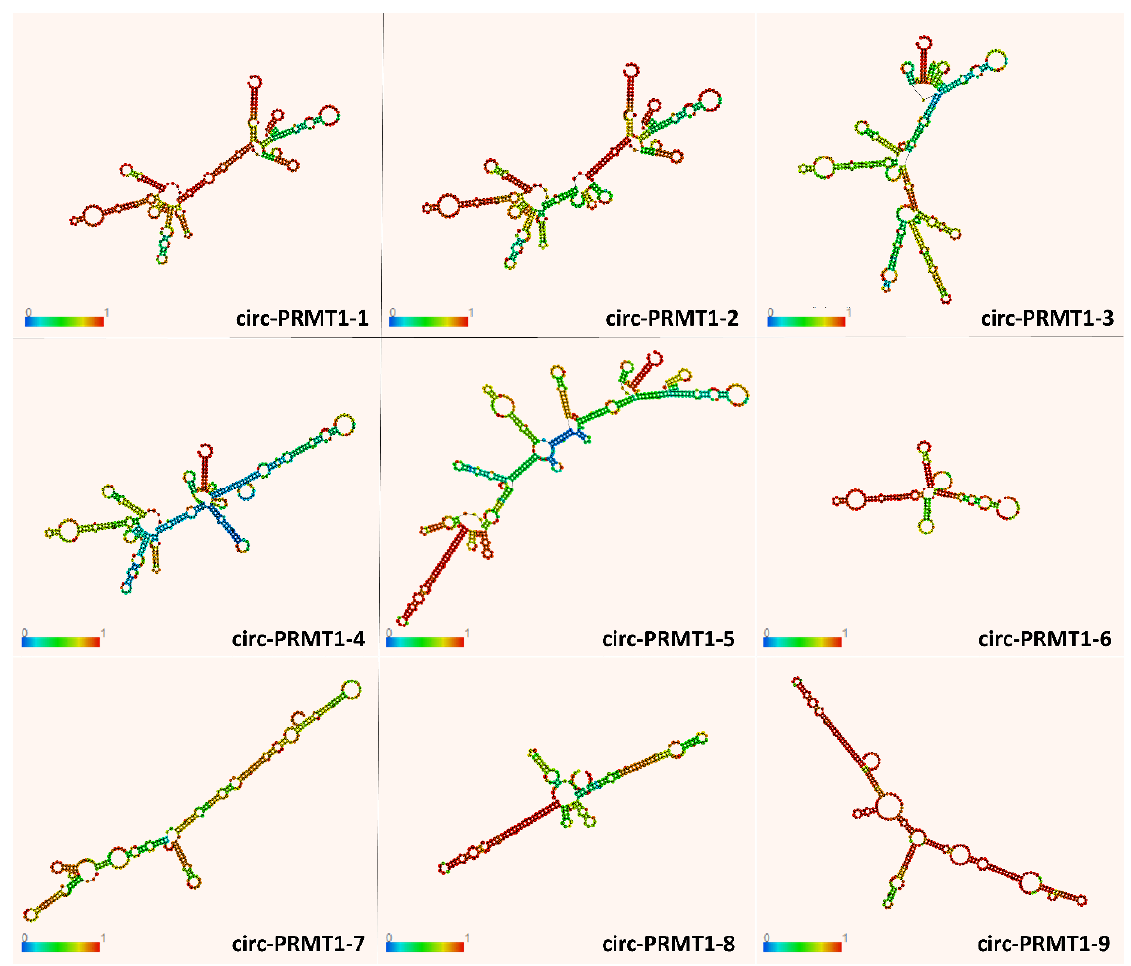
Figure 4. Graphical visualization of the secondary structures and base-pair probabilities of the novel PRMT1 circRNAs, using a loop-based energy model and dynamic programming algorithm of the RNAfold prediction tool [36] . The color scale denotes the accuracy of the minimum free energy and partition function: dark blue signifies the lowest base-pairing probability, while dark red signifies the highest base-pairing probability.